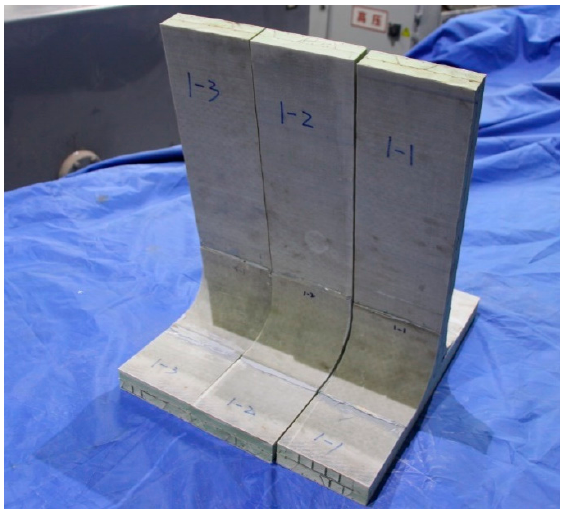
Figure 5. Specimens of T-joint.